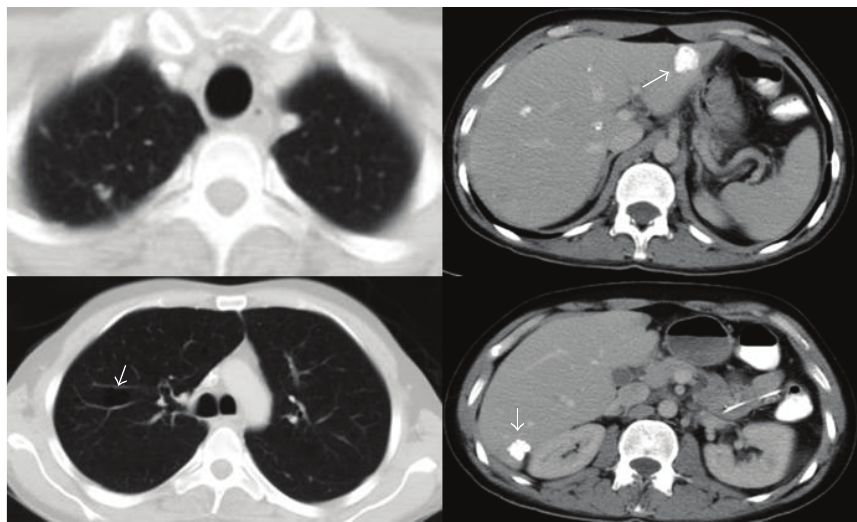
Figure 3: Complete response in July 2013 in the lungs and